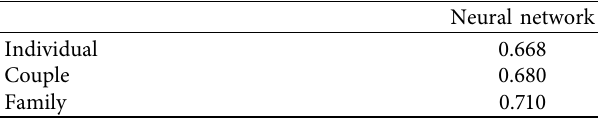
Table 5: Accuracy of the NN algorithms after training the model on the data retained from the